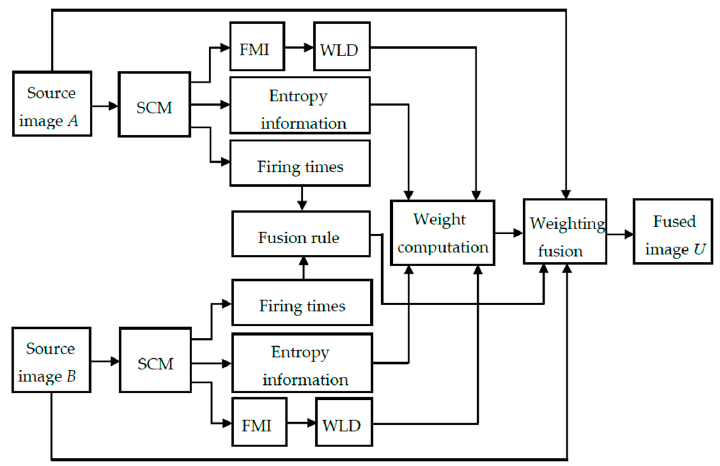
Figure 3. The flowchart of the SCM-M method.